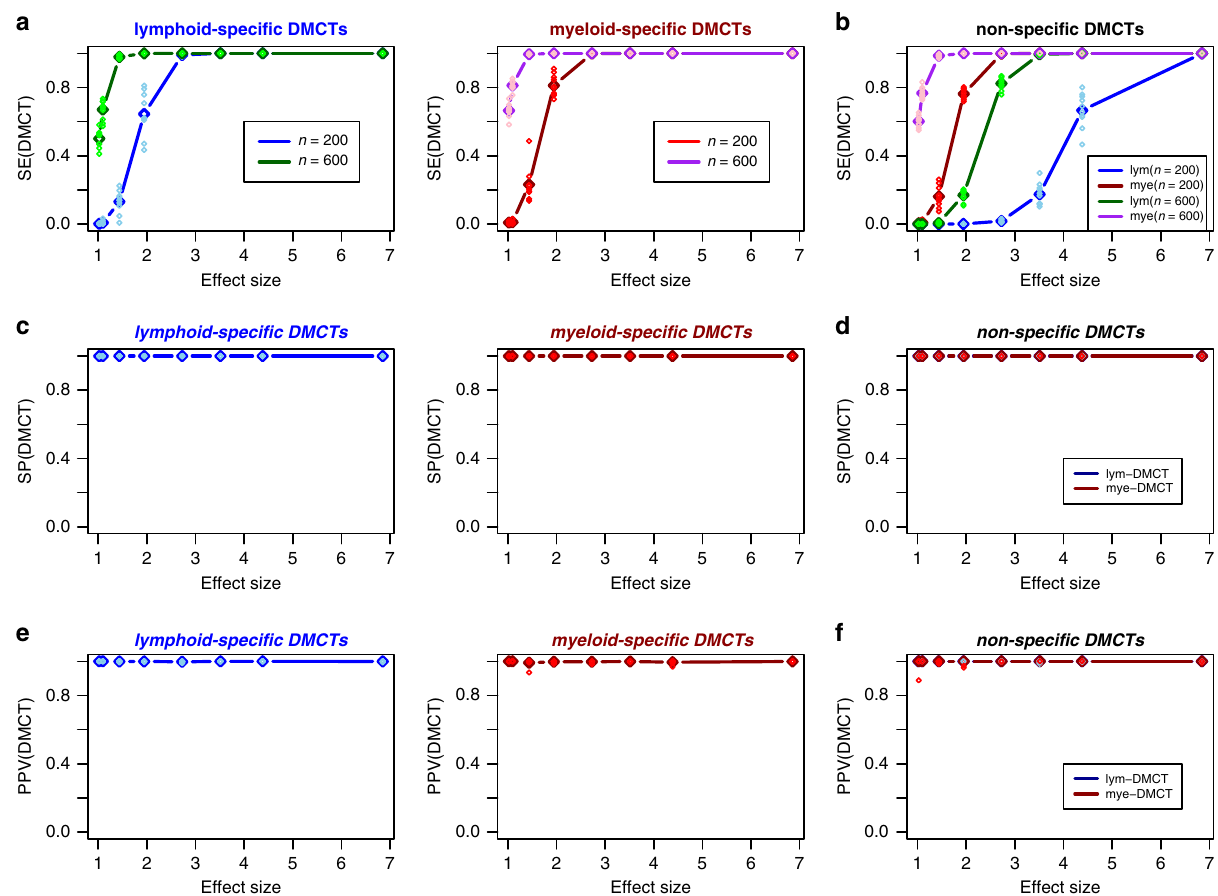
Fig. 5 Simulation-based power estimates for detecting lymphoid and myeloid DMCTs. a Plot of the sensitivity to detect lymphoid and myeloid speci fi c DMCTs ( y -axis) vs. the smoking effect size ( x -axis). Data points represent the mean sensitivity, as obtained over 10 different Monte-Carlo simulations, encompassing 482,077 CpGs of which 1000 are DMCTs. Darkblue/darkred datapoints are for n = 200 (100 cases and controls), darkgreen/purple are for n = 600 (300 cases and controls). Each sample is an in silico mixture of real DNAm pro fi les representing one puri fi ed CD4 + T-cell and one monocyte sample. For each case sample, 1000 DMCTs at the given average effect size in only one of the two cell-types was generated. The sensitivities for each of the ten Monte-Carlo runs are shown in skyblue/red. b As a , but now for the scenario where the DMCTs are introduced at the same CpG in both cell-types. Sensitivity to detect the DMCT in the lymphoid and myeloid lineage is shown. c , d As a , b , but now for the speci fi city. e , f As a , b , but now for the precision or positive predictive value (PPV). Speci fi city and PPV values for both choices of sample size are effectively